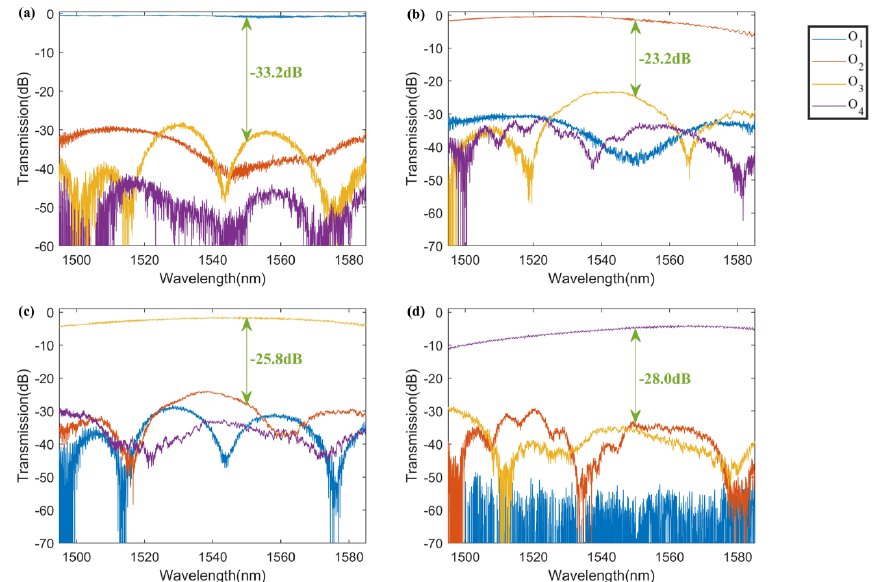
Figure 4. Measured spectral responses of the 4-channel cascaded ADCs MDM when light is launched from ( a ) I 1 , ( b ) I 2 , ( c ) I 3 , and ( d ) I 4